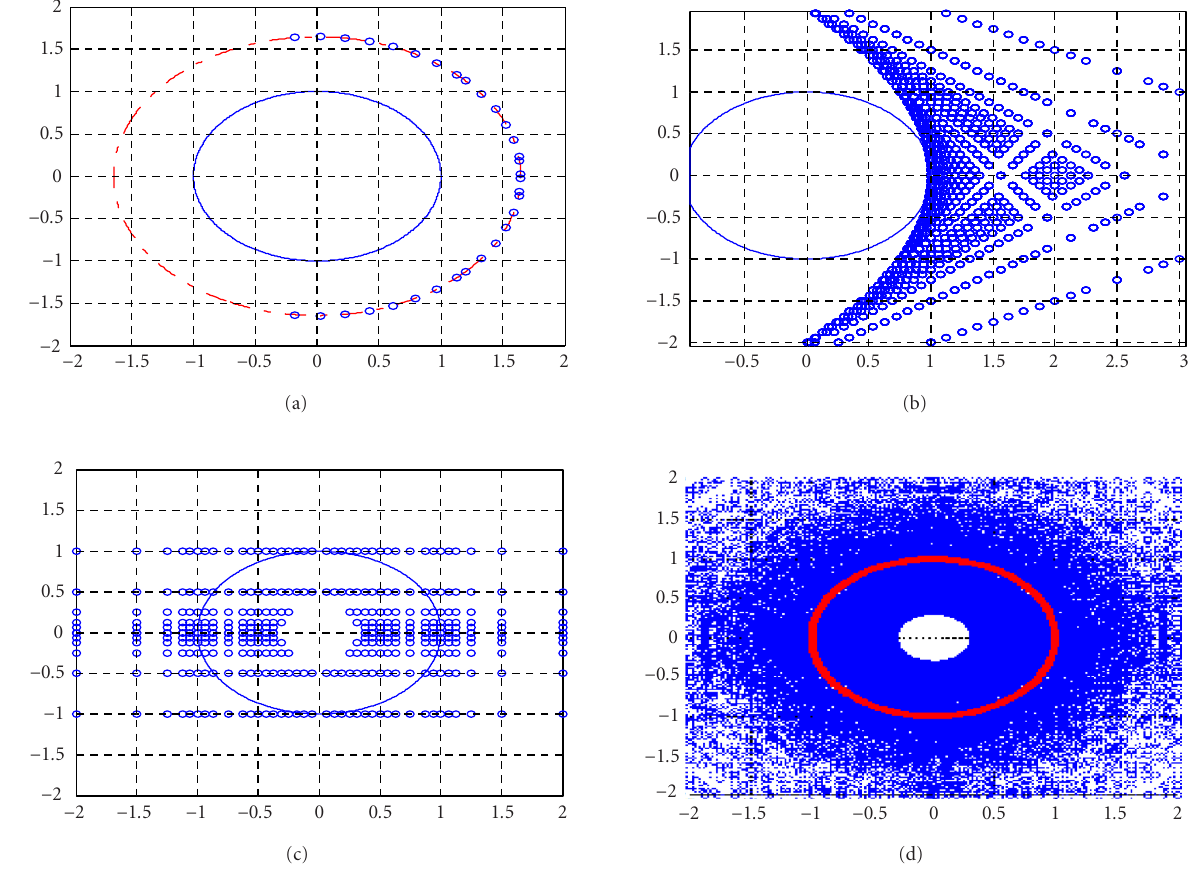
Figure 5: Constellation of reachable points under the rotation process. (a) Conventional CORDIC with N = Rm = 4. (b) EEAS-CORDIC with maximum shift range S = 4 and Rm = 2. (c) MSR-CORDIC with I = 2, J = 1, and N = 1. (d) MSR-CORDIC with I = 2, J = 1, and N = 2 for 1 / 3 (cid:1) Pn (cid:1) 3 with maximum shift range S =